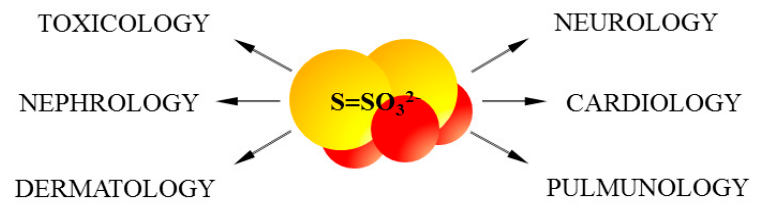
Figure 4. Thiosulfate and its therapeutic potential.